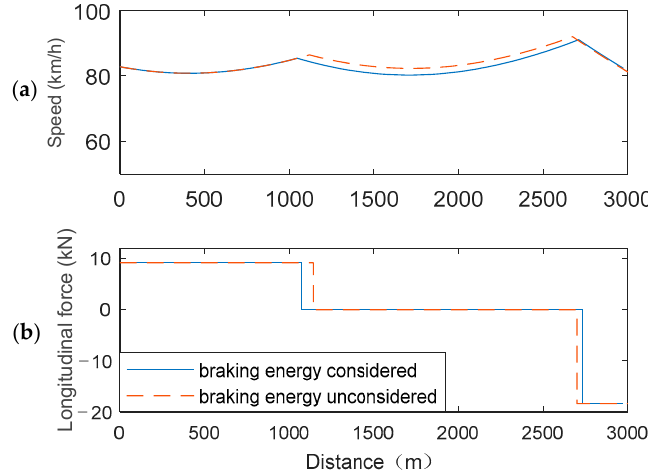
Figure 7. Optimum speed profile and its corresponding control inputs; time factor σ = 30, duration t f = 130 s/128 s. ( a ) Speed profile; ( b ) control input profile.